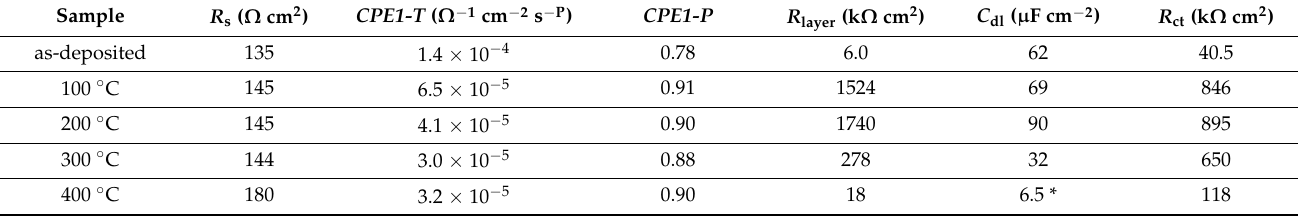
Table 4. Fitting results for impedance spectra recorded after 168 h immersion in 0.05 mol dm − 3 NaCl solution of nickel coatings before and after post-deposition heat treatment. Model III from Figure 10 was used in the calculations.